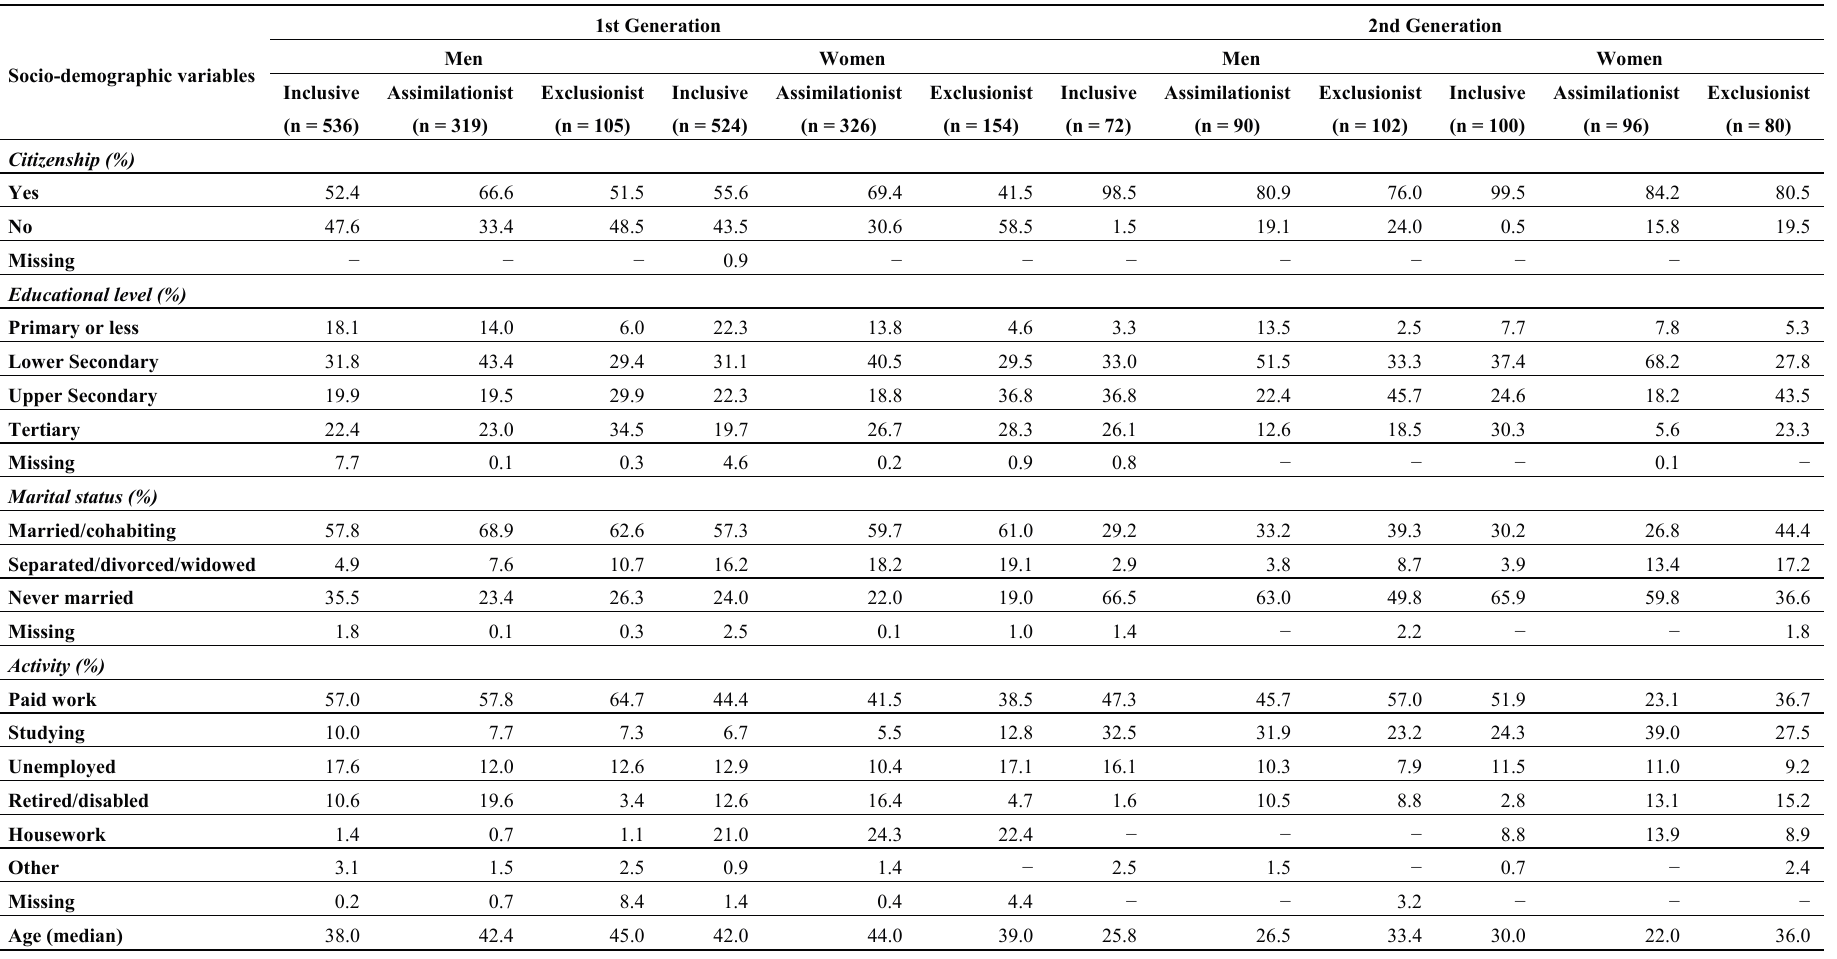
Table 1. Sample descriptive percentages, according to immigrant background, sex and national immigrant integration policy.